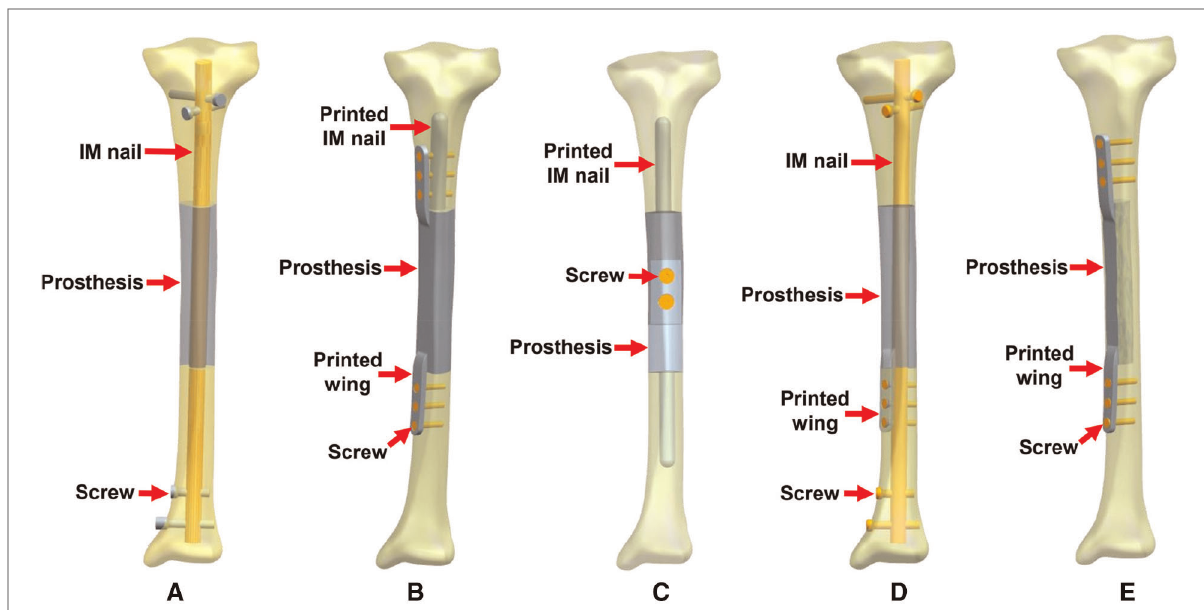
FIGURE 4 Five types of 3D printed prostheses and fi xation modes (IM: intramedullary). ( A ) Mode I: the cylindrical prosthesis was fi xed by an interlocking IM nail. ( B ) Mode II: the prosthesis with integrally printed IM nail and wings was fi xed by screws. ( C ) Mode III: the assembled prosthesis with integrally printed IM nails was fi xed by screws. ( D ) Mode IV: the prosthesis with integrally printed wing was fi xed by interlocking IM nail and screws. ( E ) Mode V: the prosthesis with integrally printed wings was fi xed by screws.